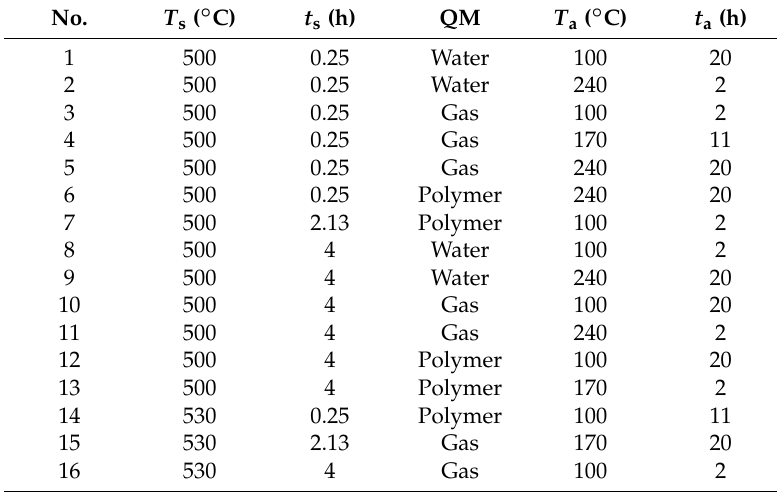
Table 3. Heat treatment experiments needed to create the regression